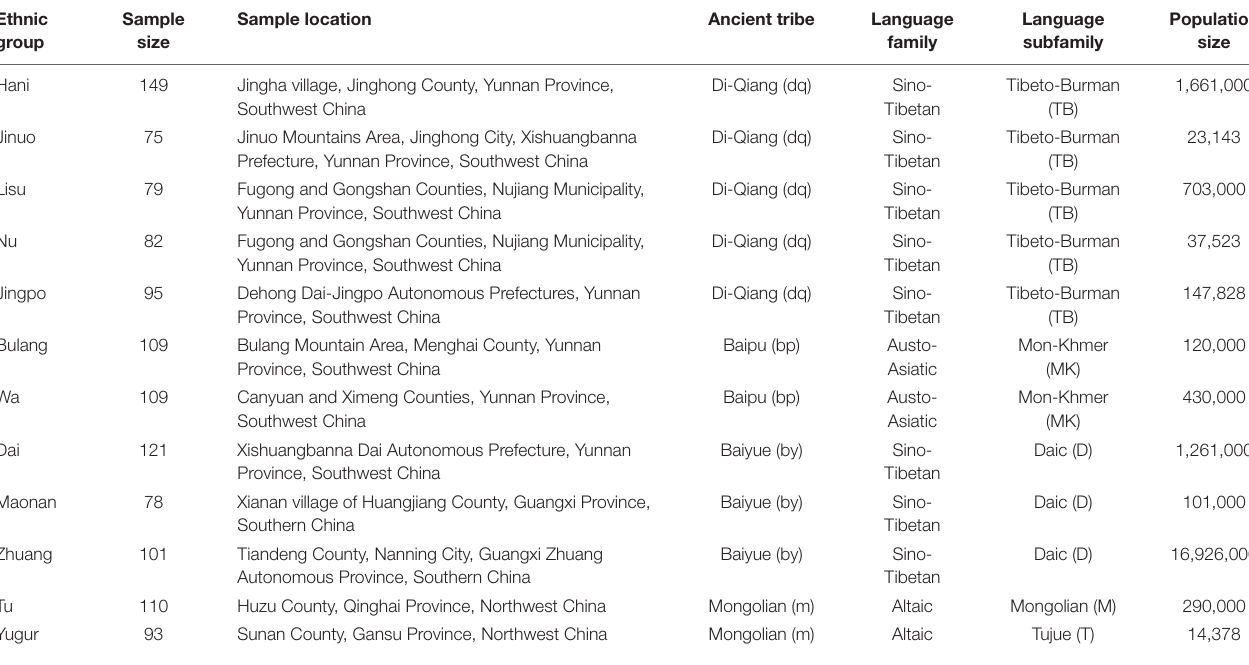
TABLE 1 | Geographic and language information for the 12 minority ethnic populations sampled in the current study. Ethnic Sample group